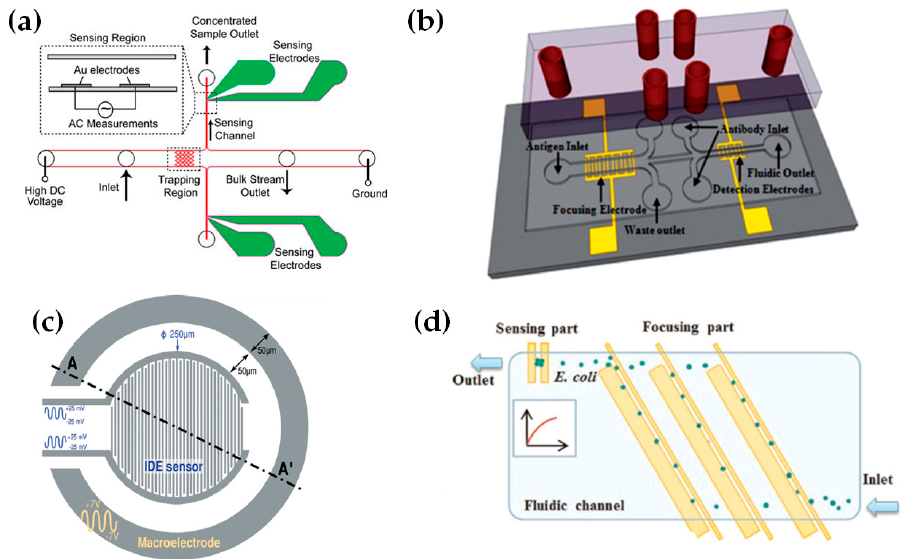
Figure 4. Schematic of bacteria concentration and detection approaches using DEP and AI. ( a ) This device selectively concentrates pathogens on the base of their size by DEP and high DC voltage. The concentrated sample is released for the measure of AC impedance by a pressure-driven flow [46]; ( b ) Design of a DEP and IA device with two IDAMs in a SU-8 microchannel [14]; ( c ) A device containing a IDAM (for capacitive sensing) and a macroelectrode (for electrokinetics). A cross.section of the AA’ plane [37]; ( d ) Design of the sensor consisting of a pDEP region and a sensing region that employs dielectrophoretic impedance measurements [30].